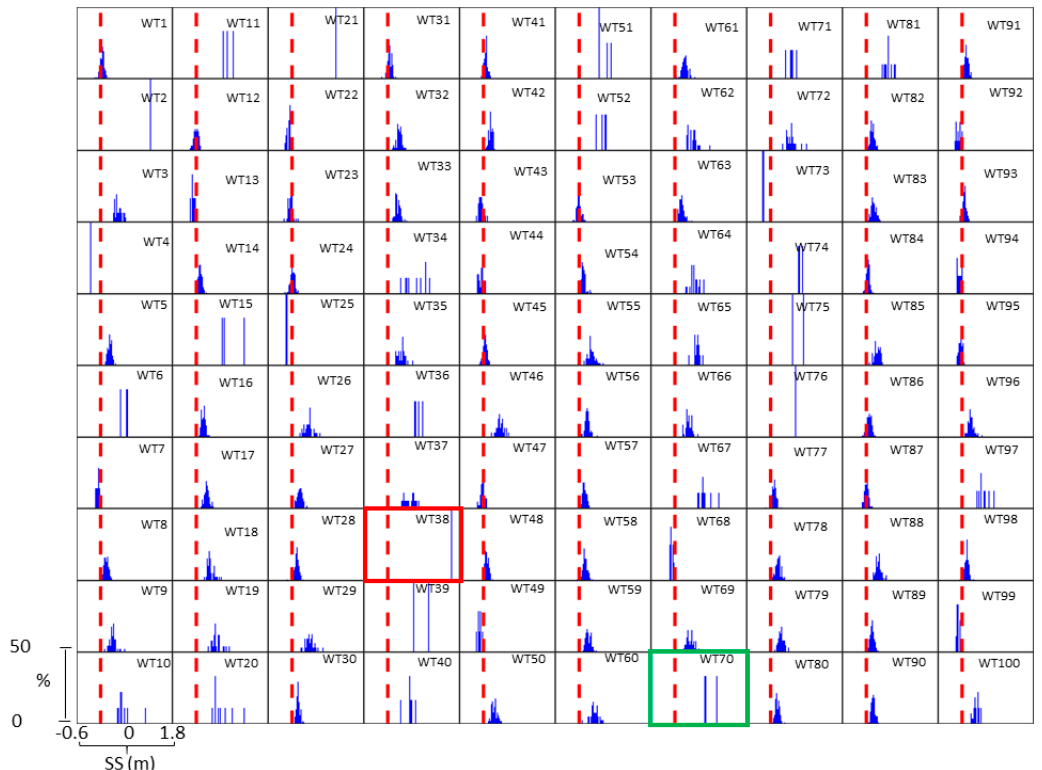
Figure 8. SD1 inferred distribution of daily maximum storm surge (SS) for each SD1 weather type (Figure 7). The dashed red line refers to the value of 0 m. Calibration period: years from 2000 to 2014, excluding 2012, which is the validation period. WT 38 and WT 70 contain the Xynthia (red rectangle) and Joachim (green rectangle) storm surge responses in its associated distribution of SS.